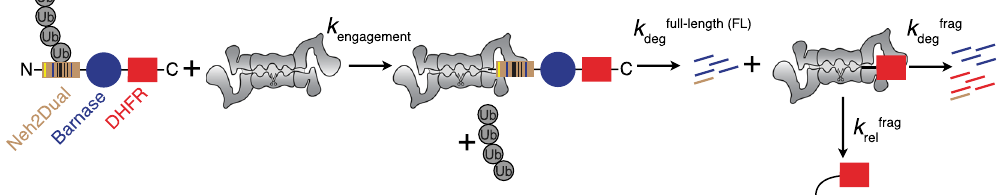
Figure 1. Schematic depiction of the assay. Substrate consists of an N-terminal Neh2Dual domain followed by a barnase domain and finally a C-terminal DHFR domain. Ubiquitinated substrate binds to the proteasome, is engaged by the proteasomal ATPases with concomitant removal of the polyubiquitin chain by Rpn11 ( k engagement ) and is degraded with the rate constant k degFL , which represents unfolding the barnase domain and progressing to the point where DHFR is stalled at the entrance to the 19S regulatory particle. At this point the proteasome can either proceed to unfold and degrade DHFR ( k degfrag ) or release a stable DHFR fragment ( k relfrag ). The partitioning between the pathways is determined by the ratio of the rate constants for the two processes. For simplicity, non-productive deubiquitination of the substrate, which can occur in competition with engagement and initial degradation, is not